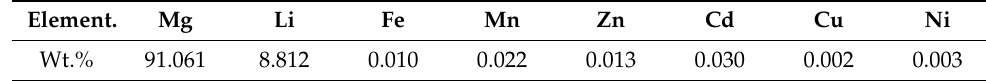
Table 1. Chemical composition of Mg-9Li alloy (wt.%). Element. Mg Li Fe Mn Zn Cd Cu Ni Wt.% 91.061